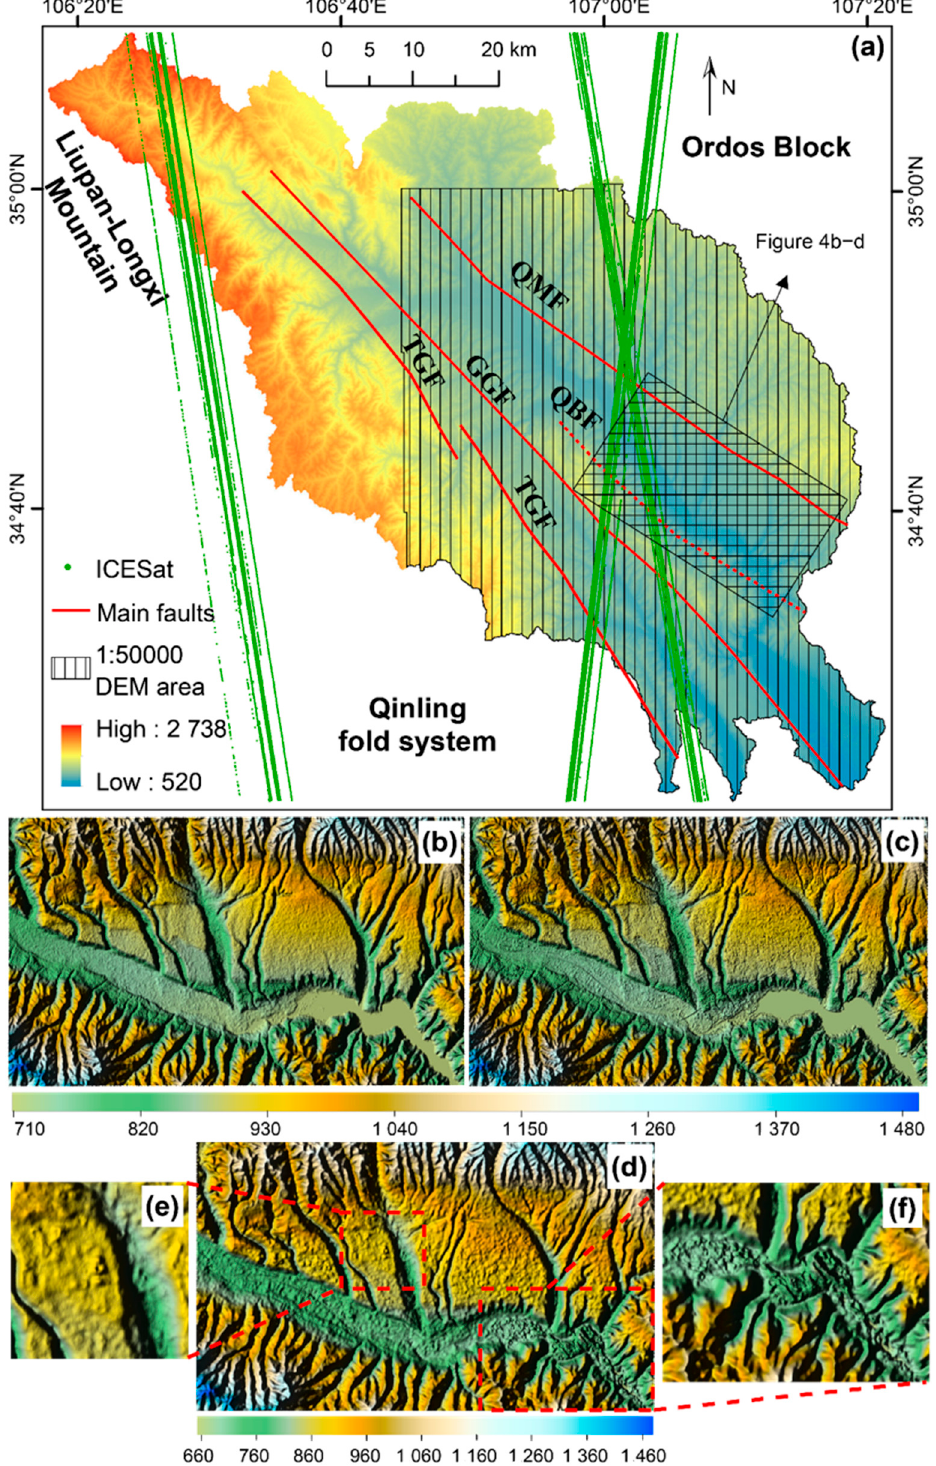
Figure 6. ( a ) The DEM was generated from ZY3 satellite stereo images in the Qianhe Basin. The ICESat/GLAH14 data is the elevation data from the National Snow and Ice Data Center (NSIDC, https://nsidc.org/data/icesat/, accessed on 18 March 2021). The 1:50,000 DEM data is collected from the fieldwork [74]. See Figure 1 for active faults names; ( b ), ( c ), and ( d ) are the hillshade maps of the Loess Platform for the Shuttle Radar Topography Mission (1” × 1”) (SRTM1), ZY3 DEM, and Reflection Radiometer Global Digital Elevation Model (ASTER GDEM), respectively. The red dotted lines on ( e ) and ( f ) are the local magnified maps from ASTER GDEM,